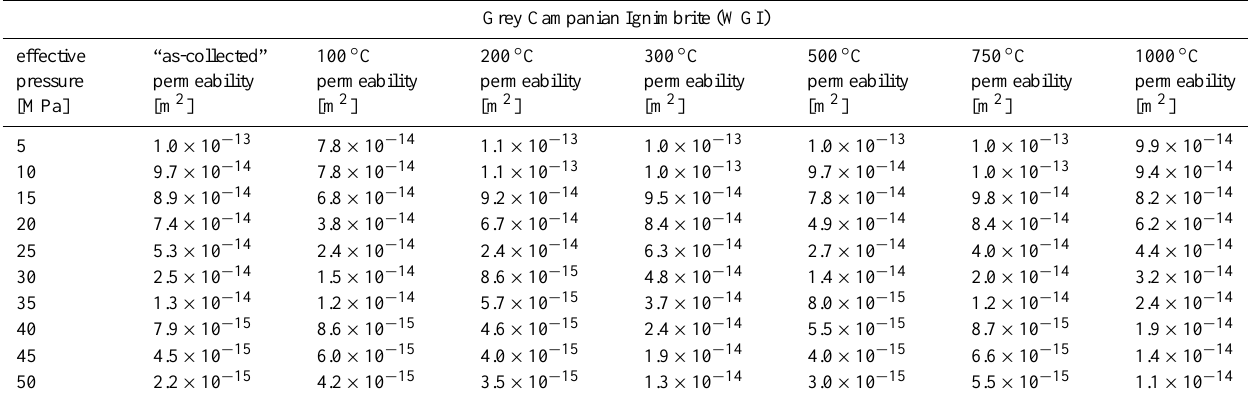
Grey Campanian Ignimbrite (WGI)